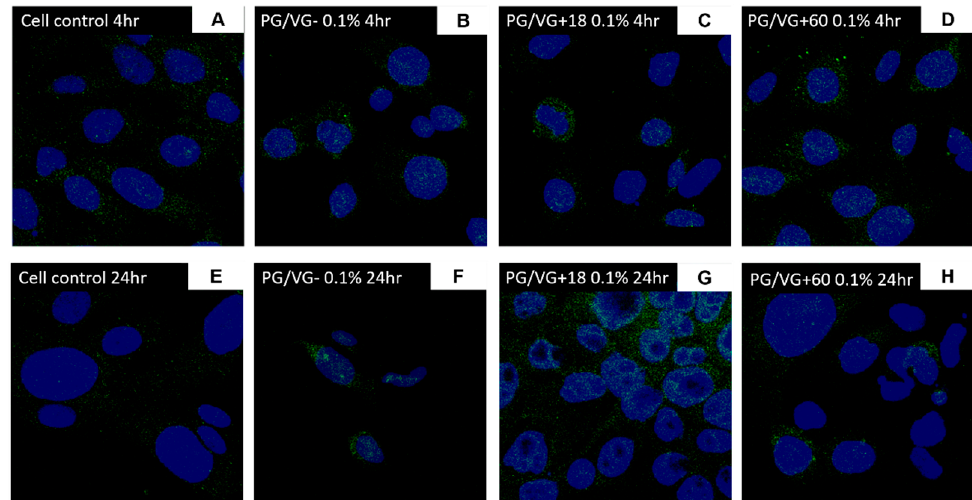
Figure 11. ACE2 protein expression of BEAS-2B cells following electronic cigarette aerosol (PG/VG) exposure: BEAS-2B cells were exposed to a concentration (0.1%) of electronic cigarette condensate generated from PG/VG ± nicotine for 4 or 24 h. Protein expression of ACE2 was assessed through immunofluorescence staining for 4 h ( B – D ) and 24 h ( F – H ) treatments in comparison with cell controls ( A , E ). Images at 40 × .